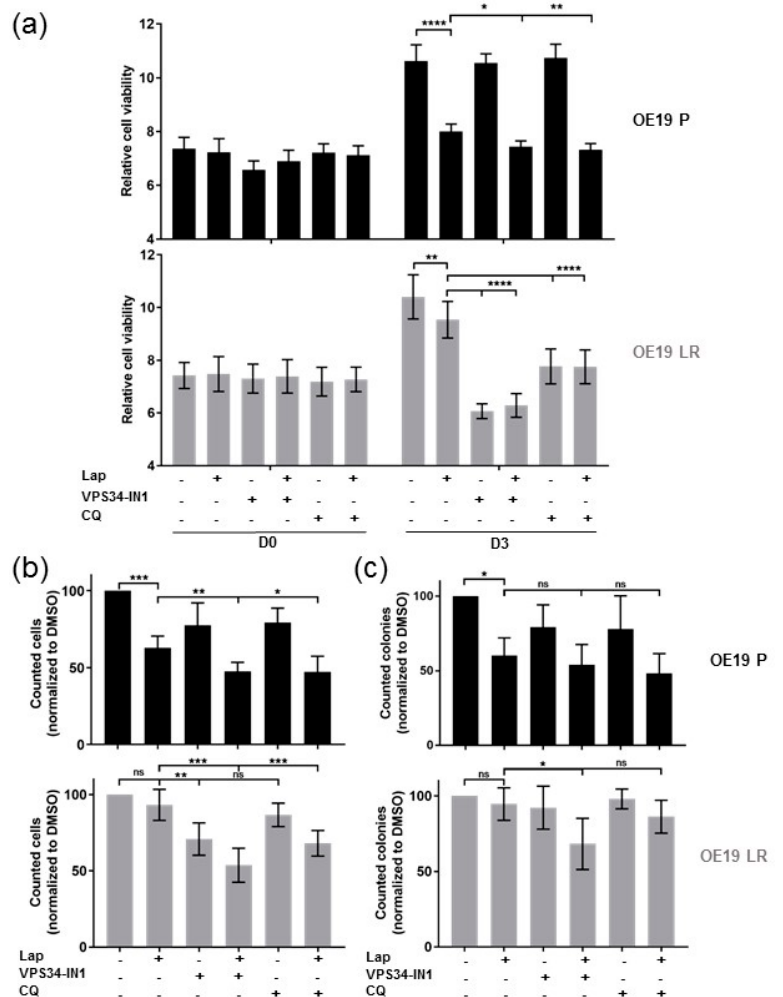
Figure 3. Combined Her2 and autophagy inhibitor treatment ( a ) Relative cell viability of OE19 cells treated with Lapatinib (120 nM) and/or autophagy inhibition either VPS34 inhibitor (VPS34-IN1) (5 µM) or chloroquine (CQ) (25 µM) at days 0 and 3 of the alamarBlue ® experiment ( n ≥ 3). ( b ) Cell counts of OE19 P and OE19 LR cells treated as in ( a ) but for 48 h. Values were normalized to DMSO control treated cells ( n = 7) ( c ) Colony numbers after treatment as described in ( b ), reseeded (2500 cells/well) in six-well plates and incubation for 14 days without treatment ( n = 5). The error bars represent SD, statistical significance was determined by Mann–Whitney U test: ns = non significant p > 0.05, * p ≤ 0.05, ** p ≤ 0.01, *** p ≤ 0.001, **** p ≤